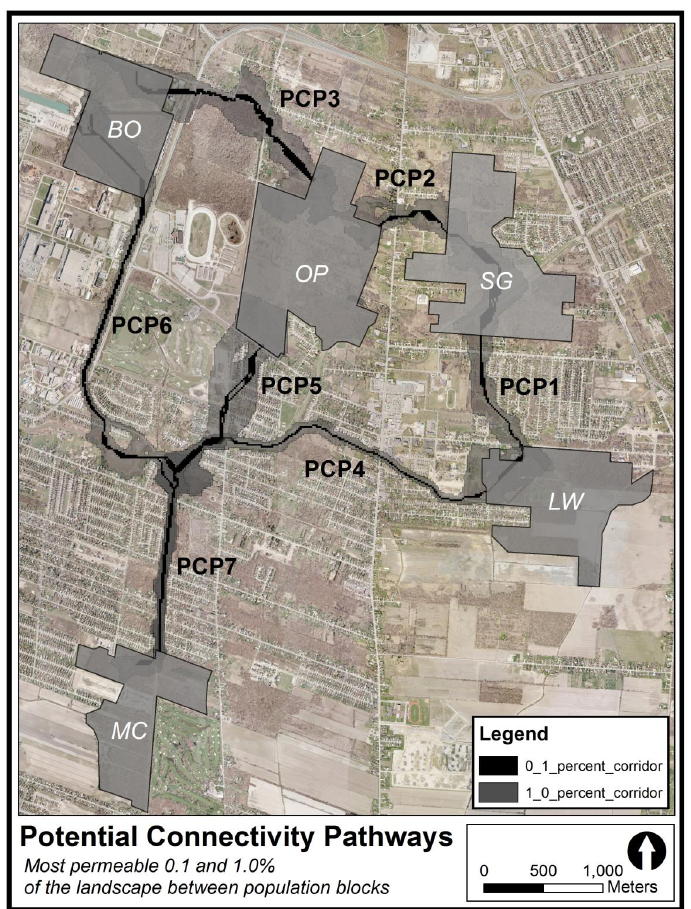
Figure 5. The most permeable 0.1% and 1.0% of the landscape between pairs of population blocks for the Massasauga rattlesnake in Windsor/LaSalle, Ontario as indicated by a cost-surface GIS